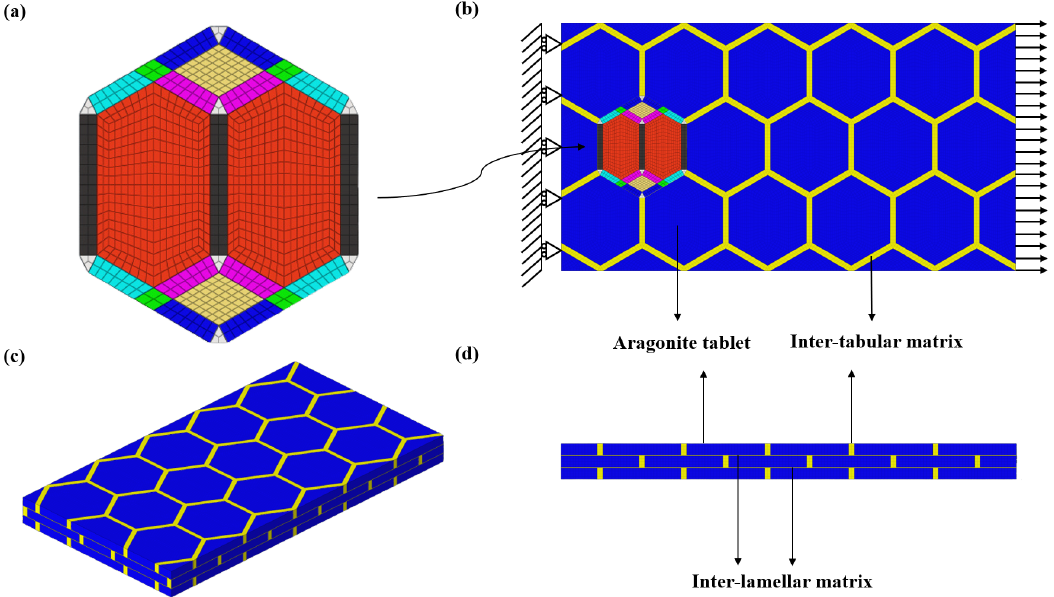
Figure 2. ( a ) Mesh partition pattern of a unit aragonite tablet surrounded by inter-tabular organic matrix; ( b ) boundary conditions; ( c ) 3D view of the nacre model; and ( d ) top view of the model resembling the brick and mortar